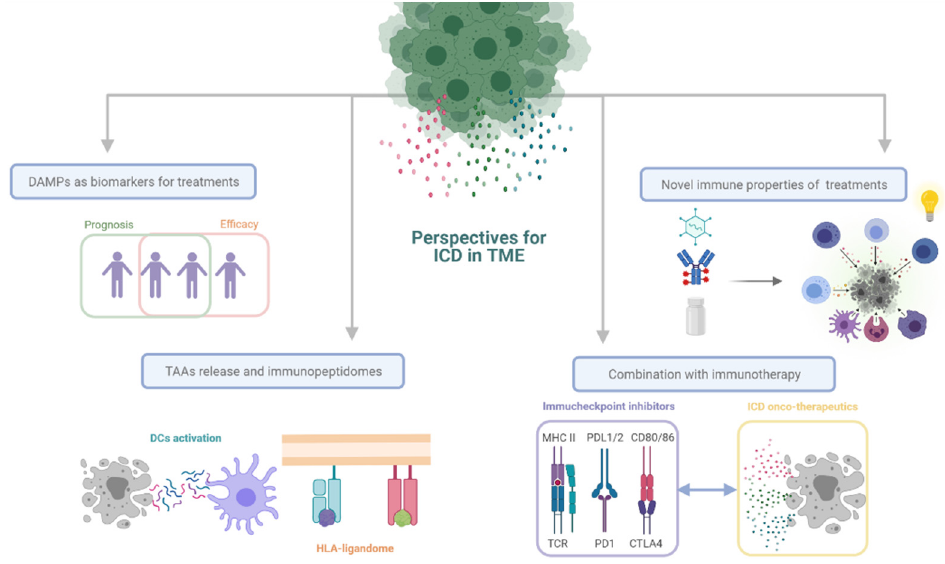
Figure 10. Different approaches for ICD in TME.